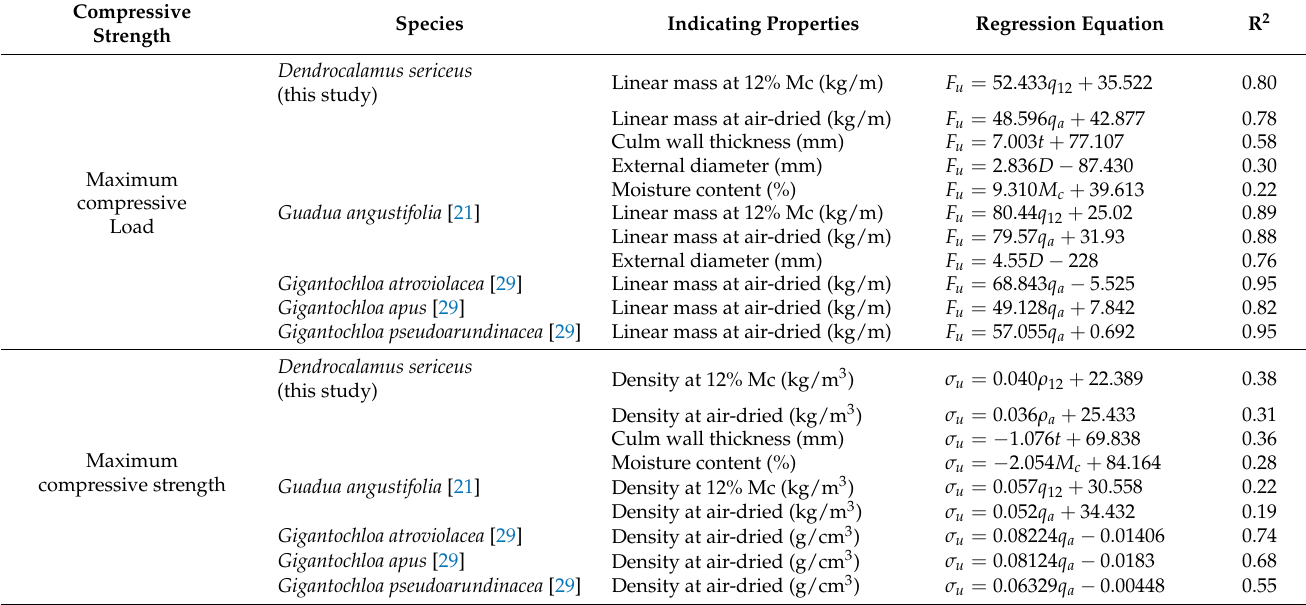
Table 8. Regression equations of compressive load and compressive strength of different bam- Table 7. Compressive load grade classification of Dendrocalamus sericeus Munro based on air-dried boo linear mass and at 12% M C.